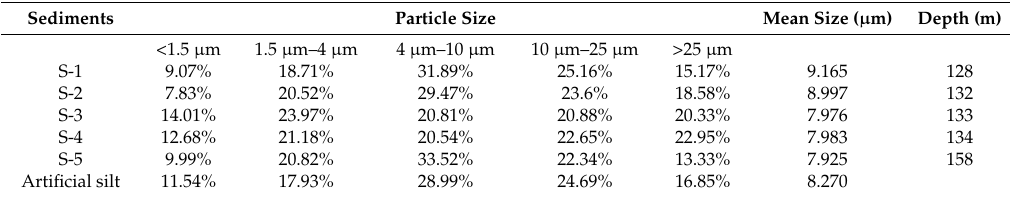
Table 1. Drilling depths and particle size distributions of different marine sediments and artificial silt. Sediments Particle Size